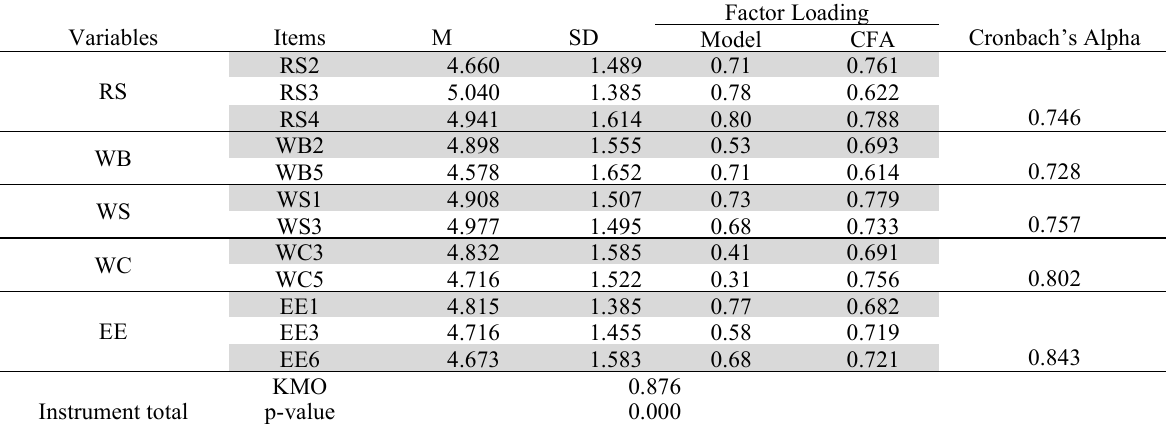
Index for the overall model fit